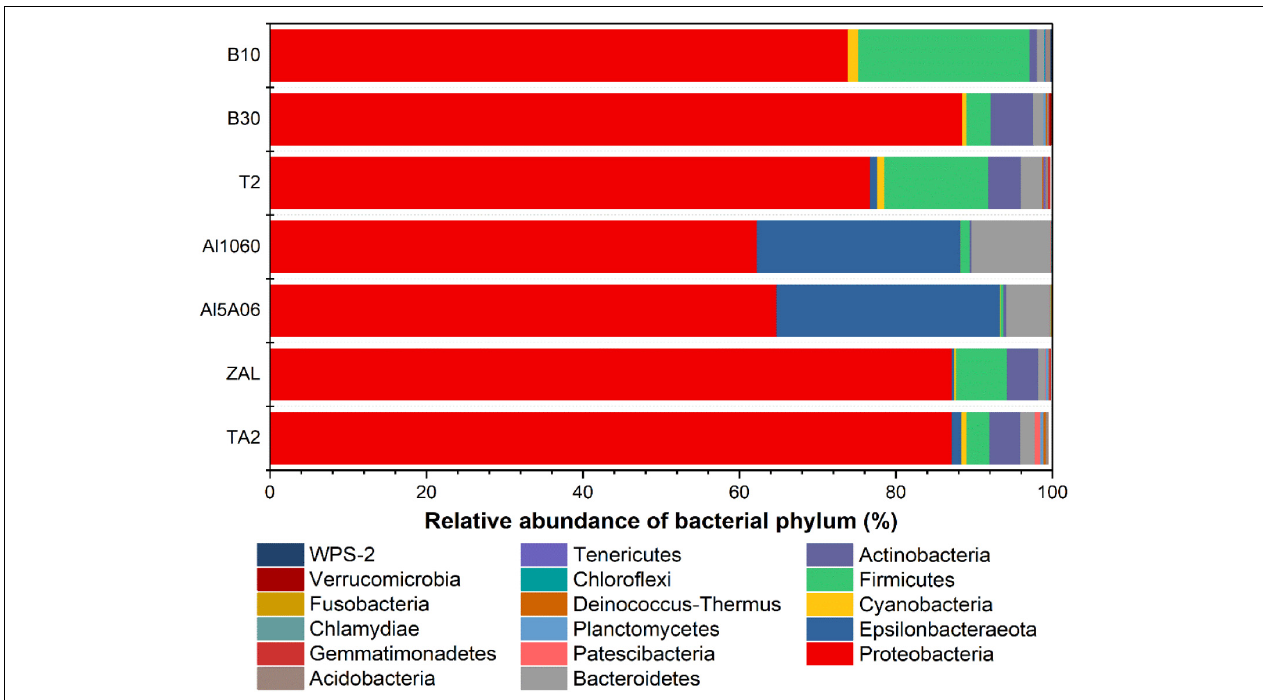
FIGURE 5 | Relative abundance of 16S rRNA gene sequences of the seven samples exposed in Yap Trench for 1 year at the bacterial phylum level (TA2, ZAL, Al5A06, Al1060, T2, B10, and B30 represented the biofilms collected from the corresponding alloy surfaces. The top 10 abundant phyla of each sample are shown in this